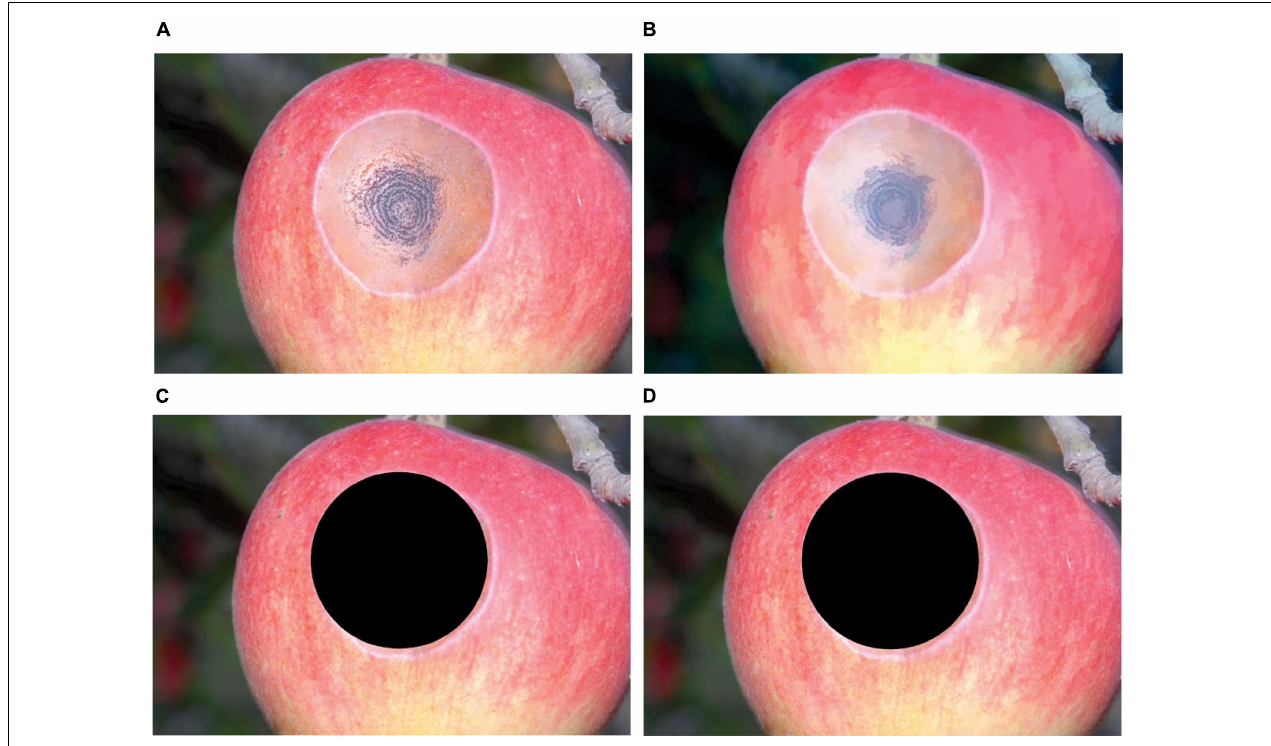
FIGURE 4 | The results of image preprocessing and lesion segmentation for apple anthracnose. (A) Original color image. (B) Image after preprocessing. (C) Image after lesion segmentation by using Lesion segmentation method 1 without closing operation. (D) Image after lesion segmentation by using Lesion segmentation method 2 with the closing operation. The black areas in panels (C,D) are the segmented lesions obtained by using Lesion segmentation method 1 and Lesion segmentation method 2, respectively.